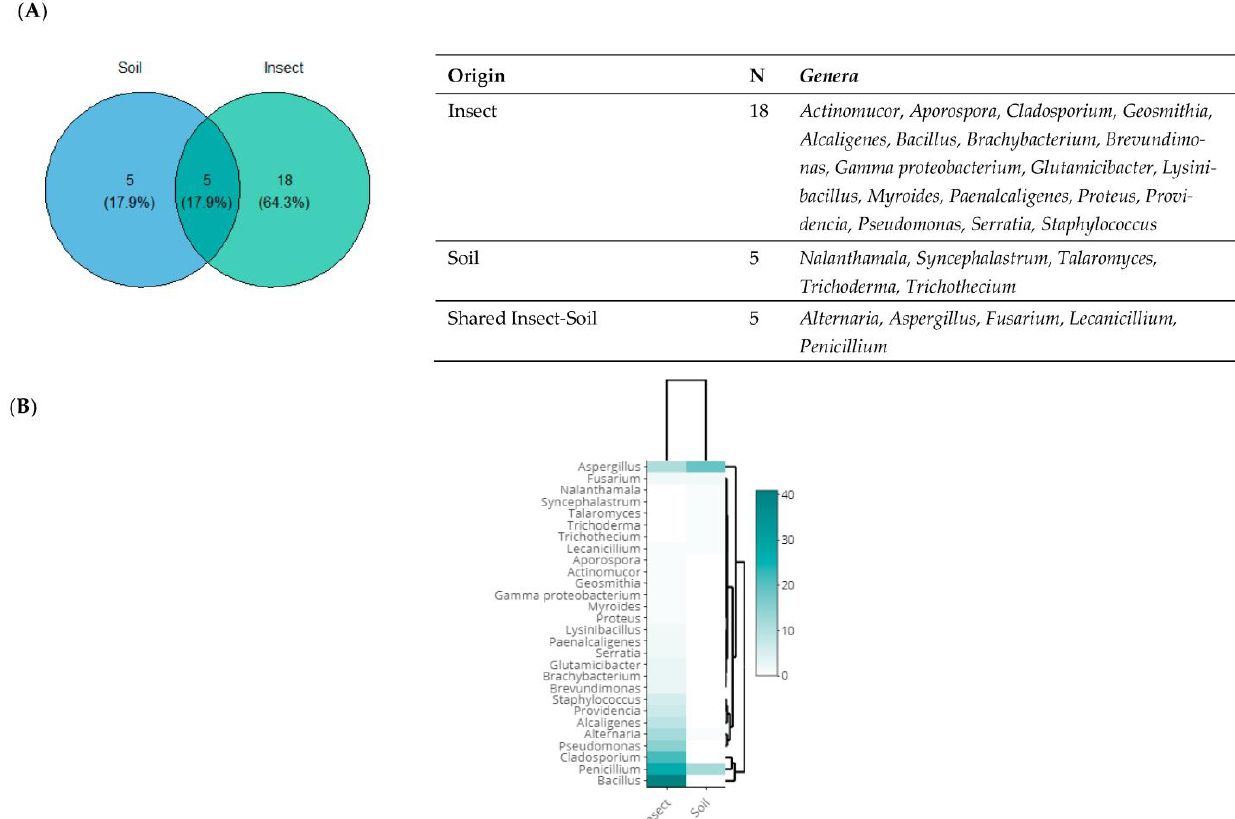
Figure 3. Taxonomic diversity according to the origin of isolation. ( A ) Venn diagram comparing the genera isolated from soil and insect (olive moth). The list of genera is presented at the right of the diagram. ( B ) Heat map of isolated genera from soil and insect. The row represents the tested isolate, and the column represents the origin of isolation. The green color corresponds to the highest values, while the white color corresponds to the lowest ones.